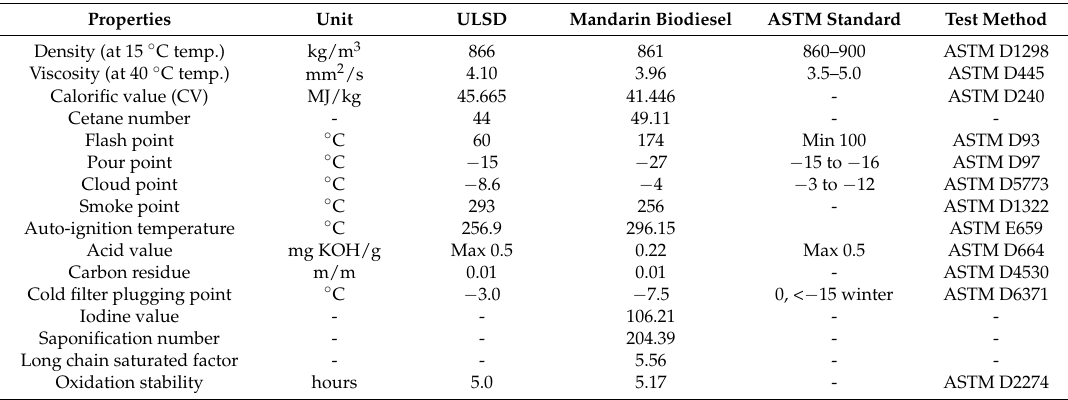
Table 5. Physio-chemical fuel properties of mandarin